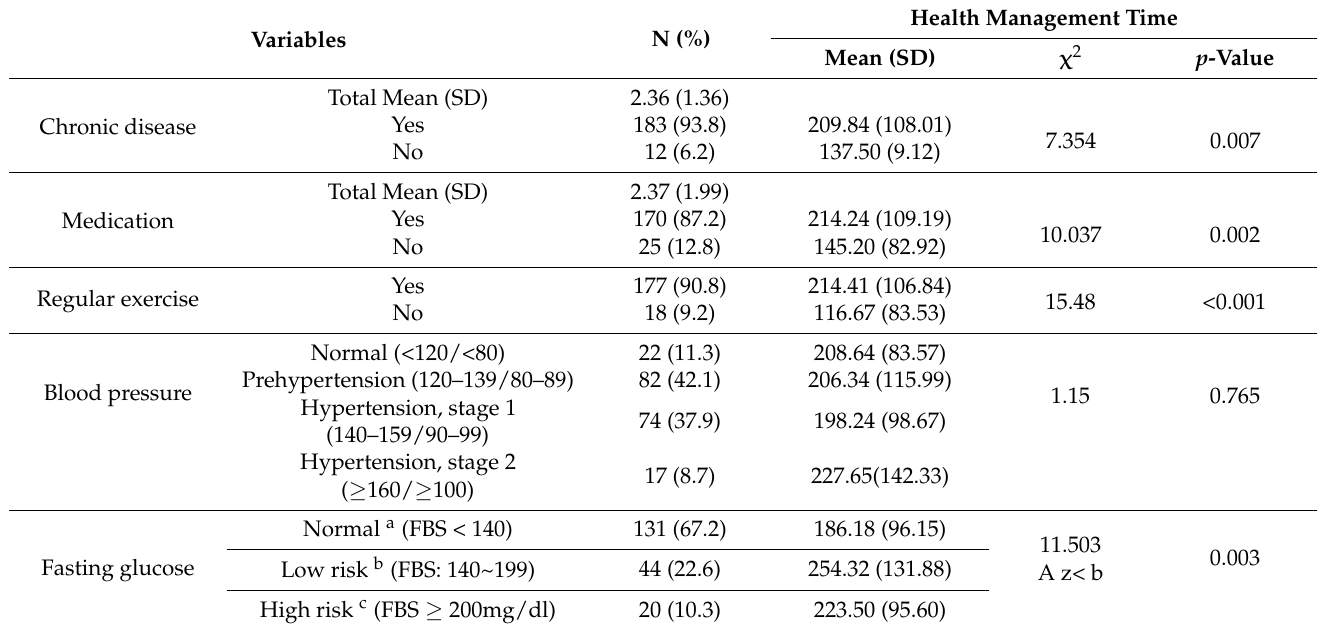
Table 4. Health status and health management time ( N =